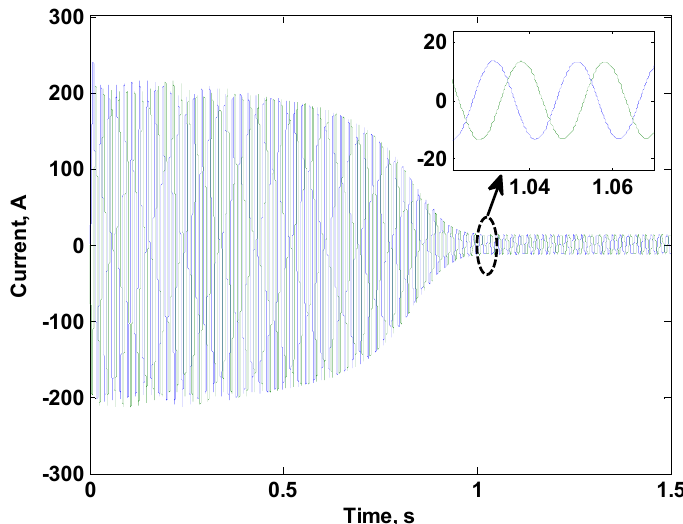
Figure 29. Motor Currents with an Open-Circuit in one of the Motor Phases.